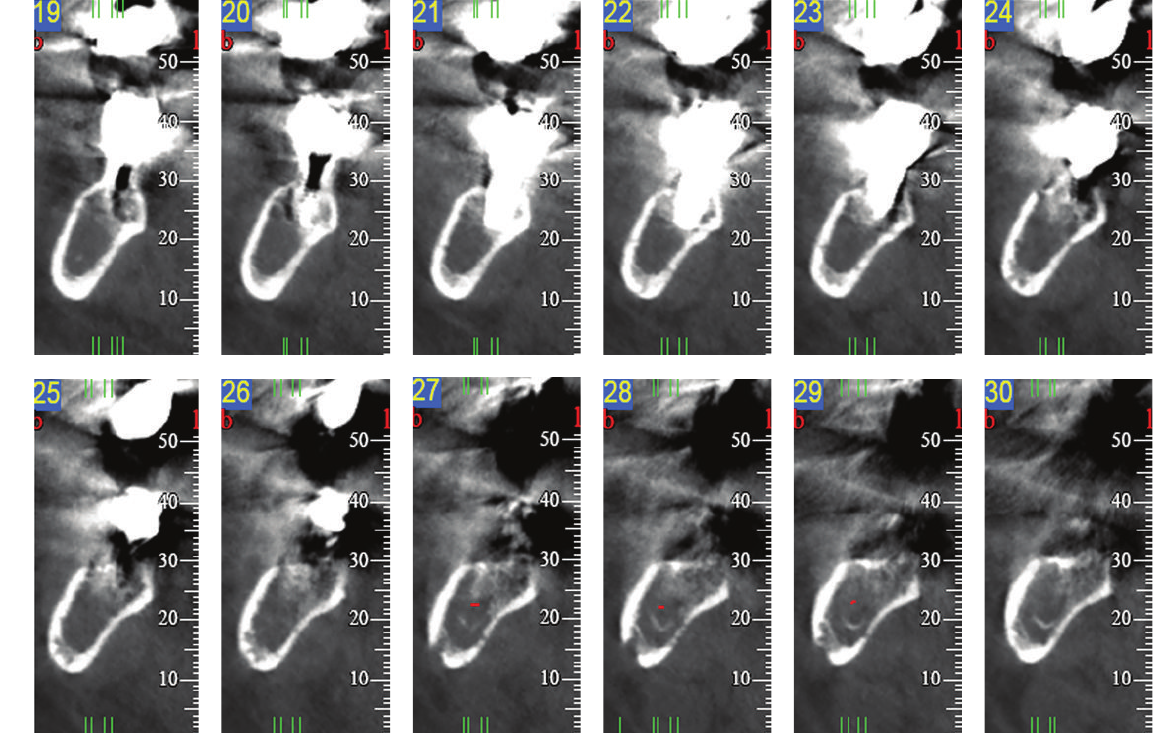
Figure 1: CT-scan examination. Note microlacunar reabsorptions of the mandibular cortices and hypodensity of the spongiosa, diffused from 4.5 to 4.8.